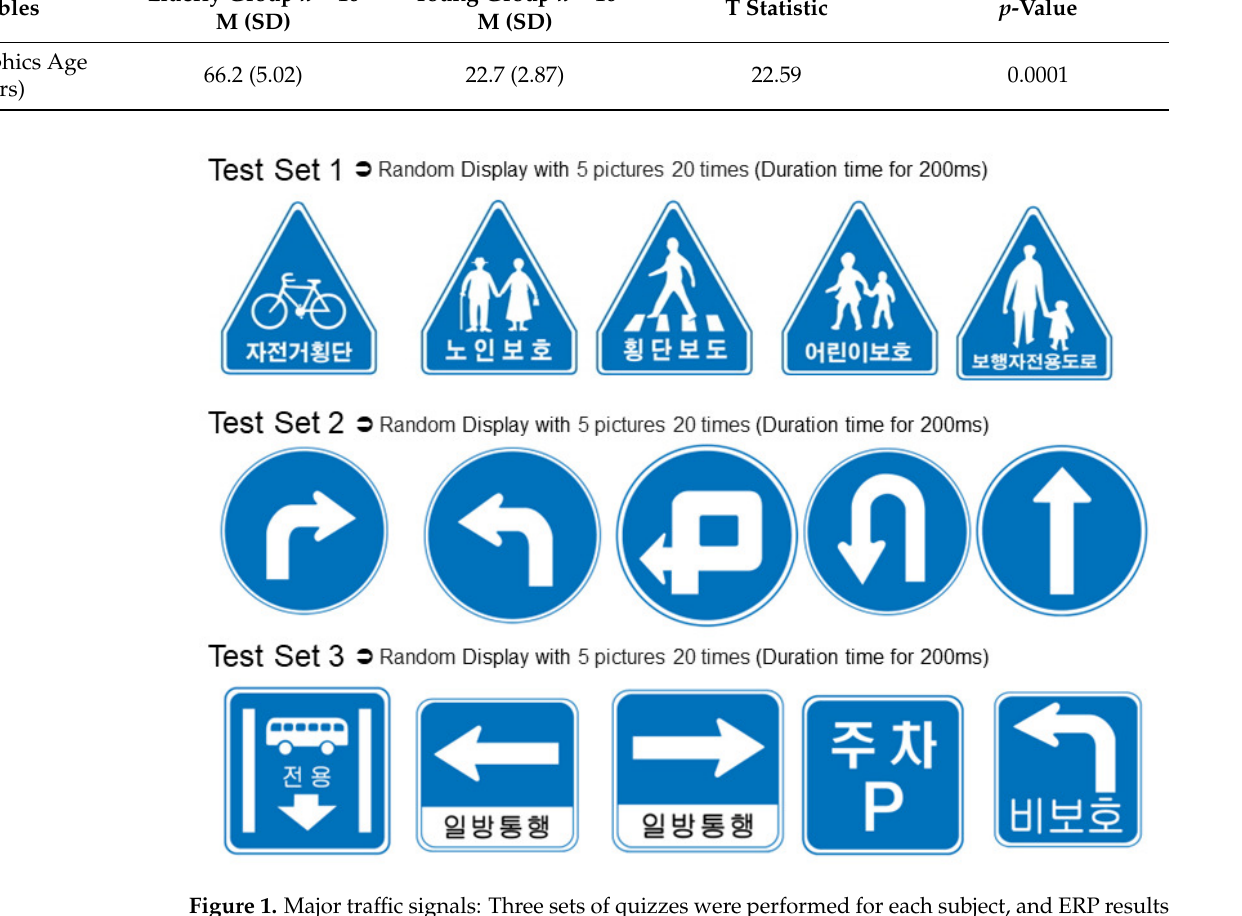
Figure 1. Major traffic signals: Three sets of quizzes were performed for each subject, and ERP results for each shape are presented in this